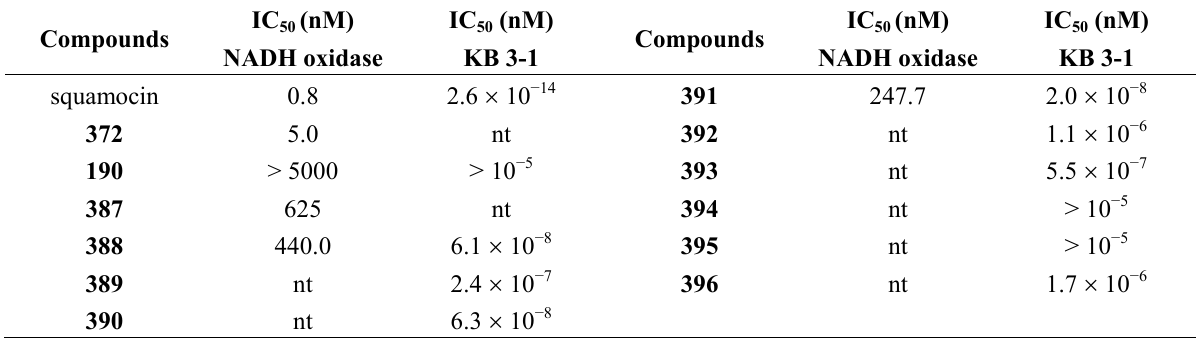
IC (nM) 50 NADH oxidase